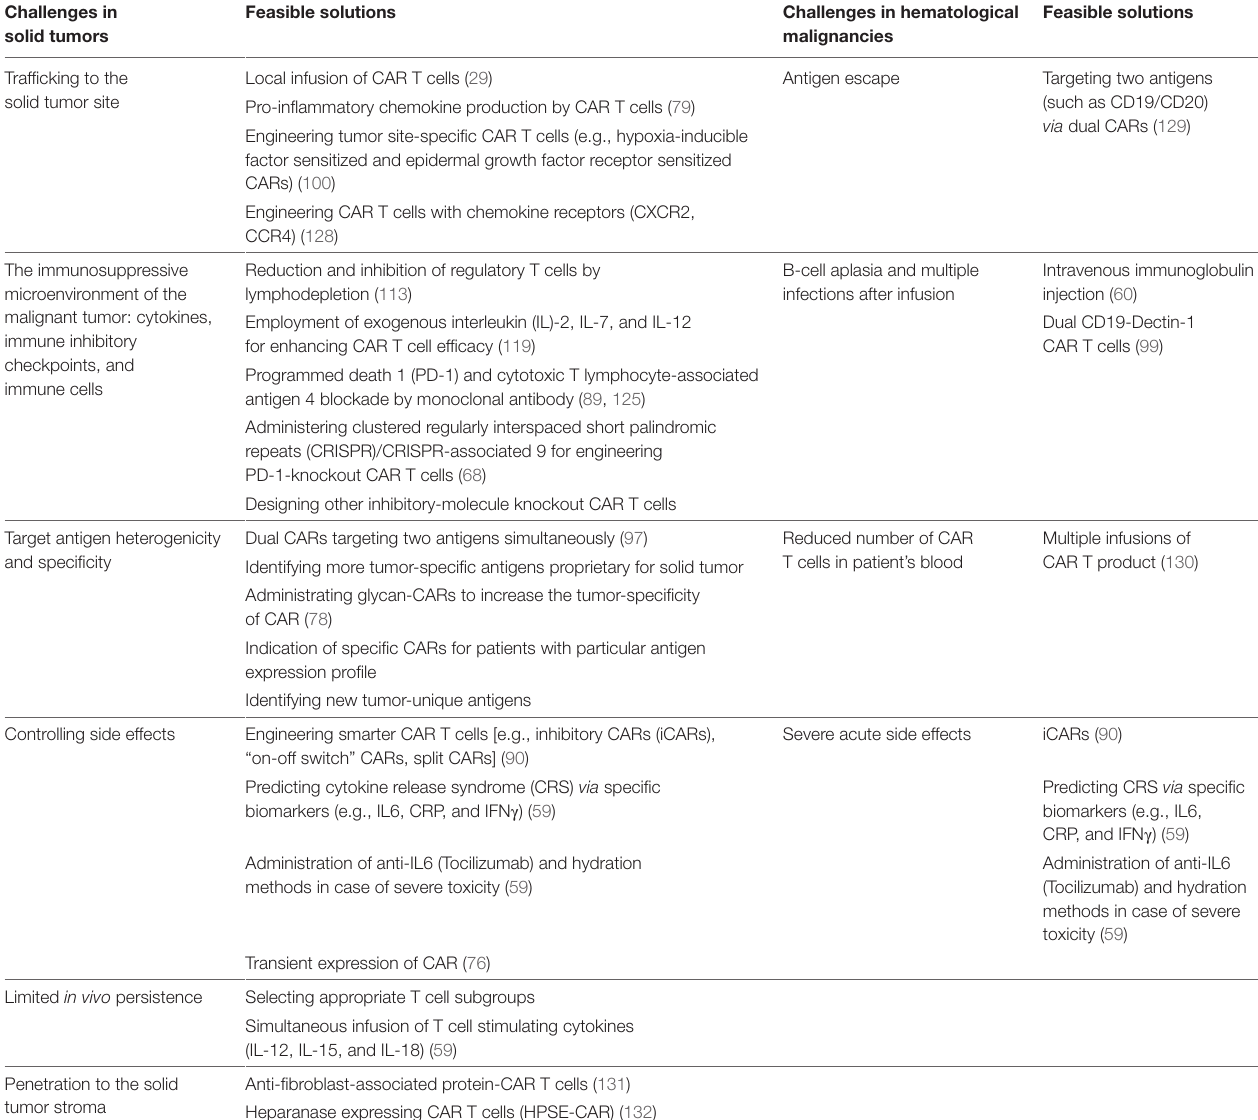
TAble 3 | A comparison of obstacles and feasible solutions of applying chimeric antigen receptor (CAR) T cells in solid tumors and hematological malignancies. Challenges in solid